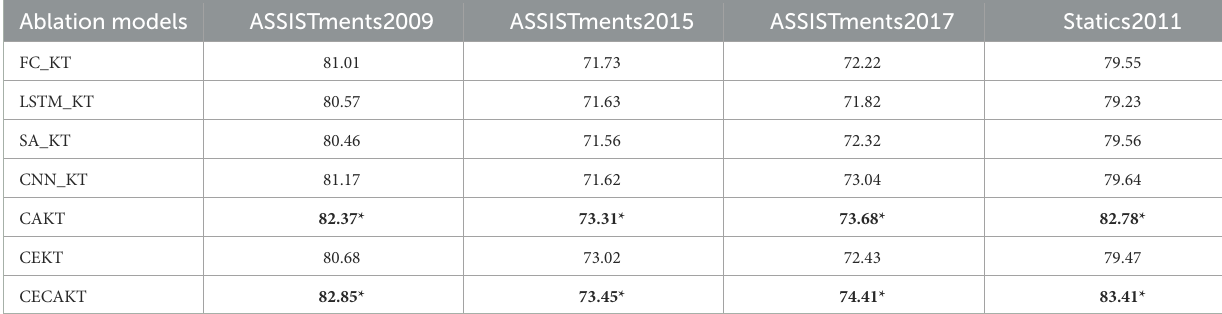
TABLE 8 The AUC results (%) of ablation study.